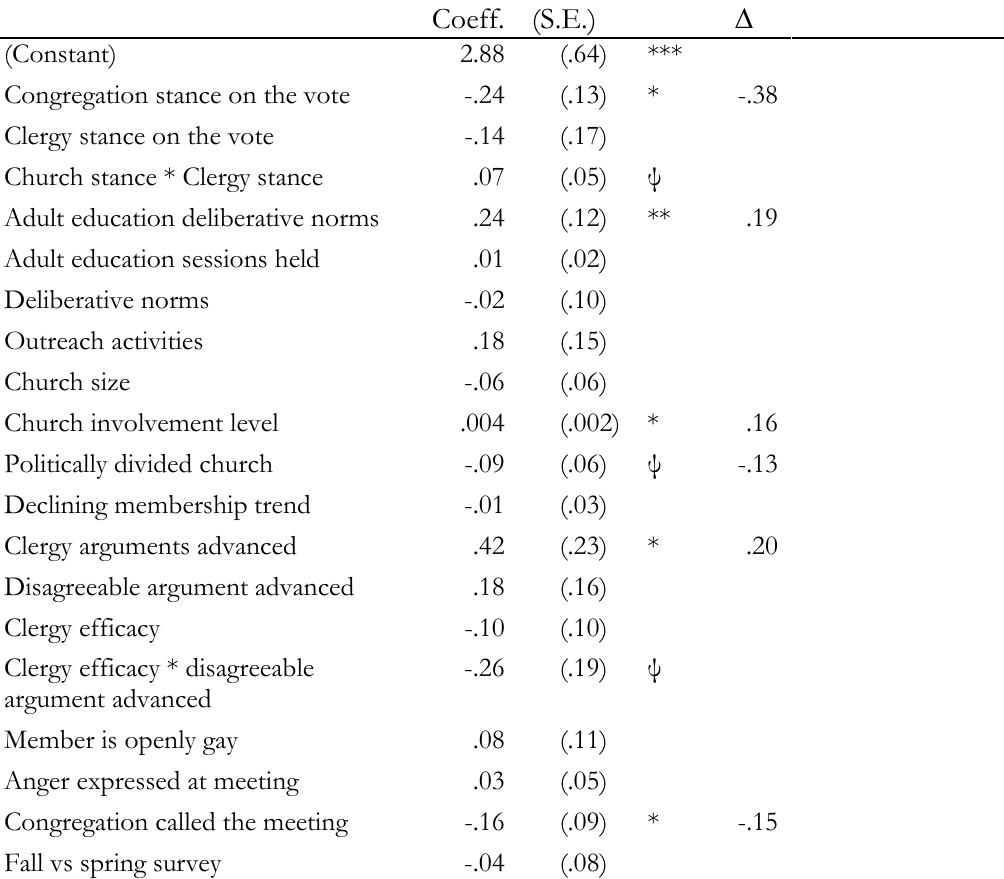
Table 2 : Deliberative Quality of Congregational Meetings on the ELCA Vote (OLS Regression